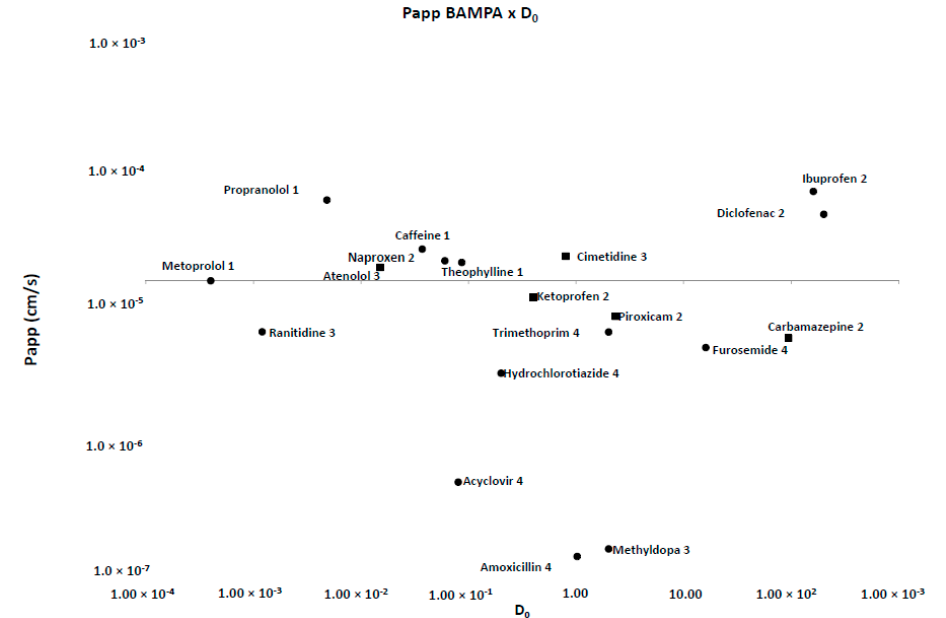
Figure 4. Permeability values for Franz-PAMPA versus D 0 drugs using metoprolol as reference drug. Most drugs ( ● ; 14 out of 19) were in accordance with previous Biopharmaceutic Classification System (BCS) classification. Some of them ( ■ ; 5 out of 19) disagreed.